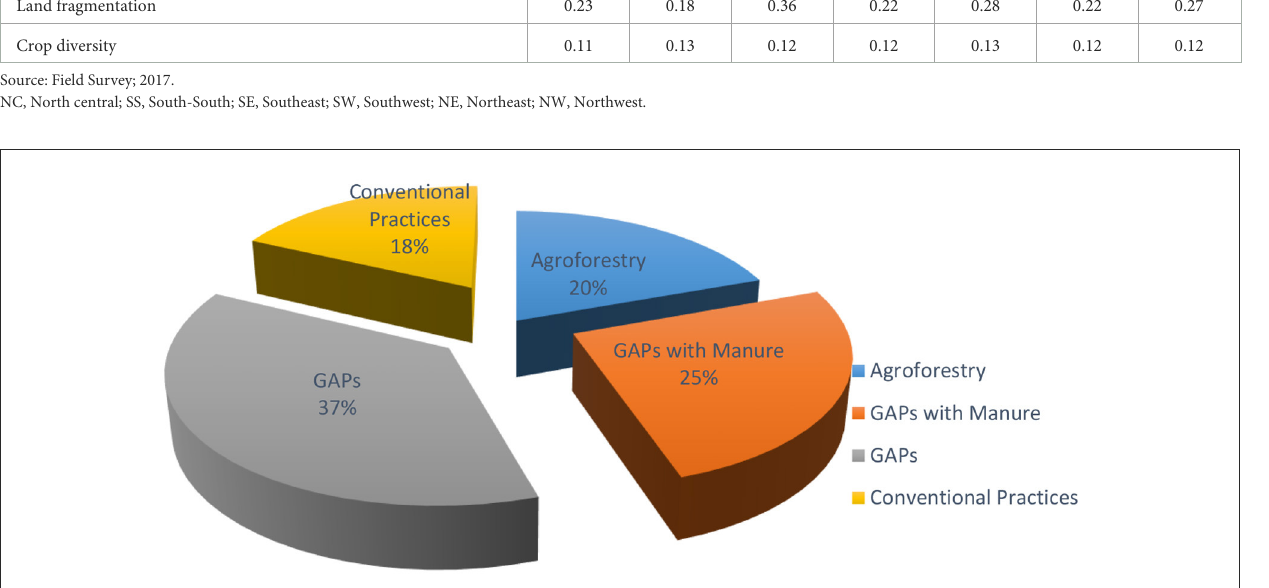
FIGURE2 Preference for RFPs among Smallholder Farmers in Nigeria. Field survey; 2017.